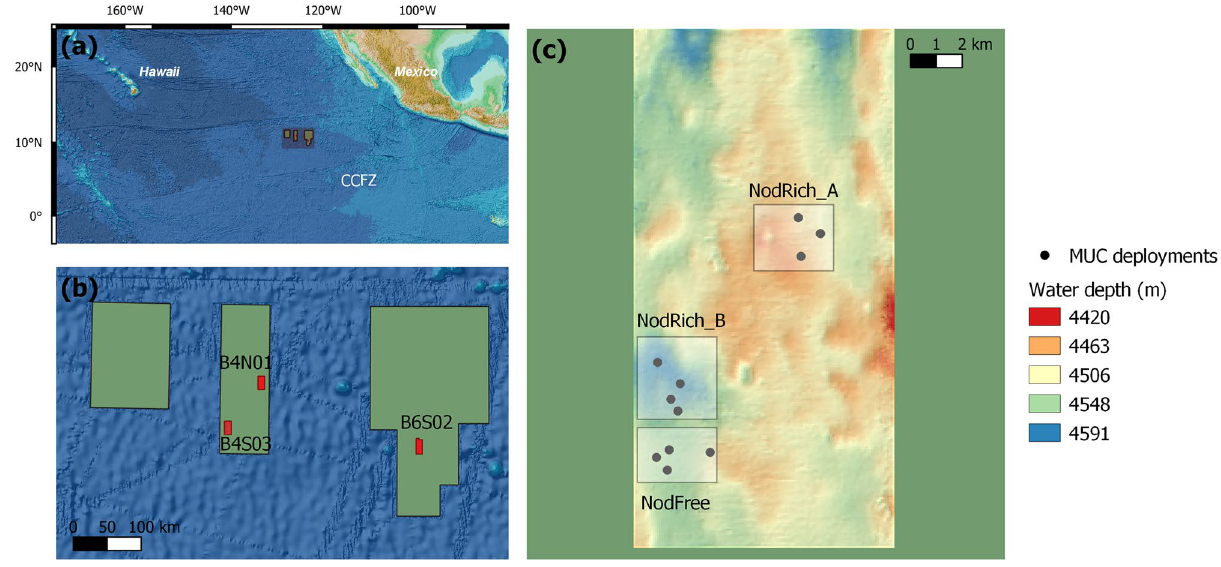
Figure 1. Maps of the sites and stations sampled. Shown are ( a ) the CCFZ with an indication of the GSR contract area, ( b ) the GSR contract area with the different sites sampled, ( c ) the nodule-free (NodFree) and nodule-rich (NodRich_A and NodRich_B) stations at site B4S03.